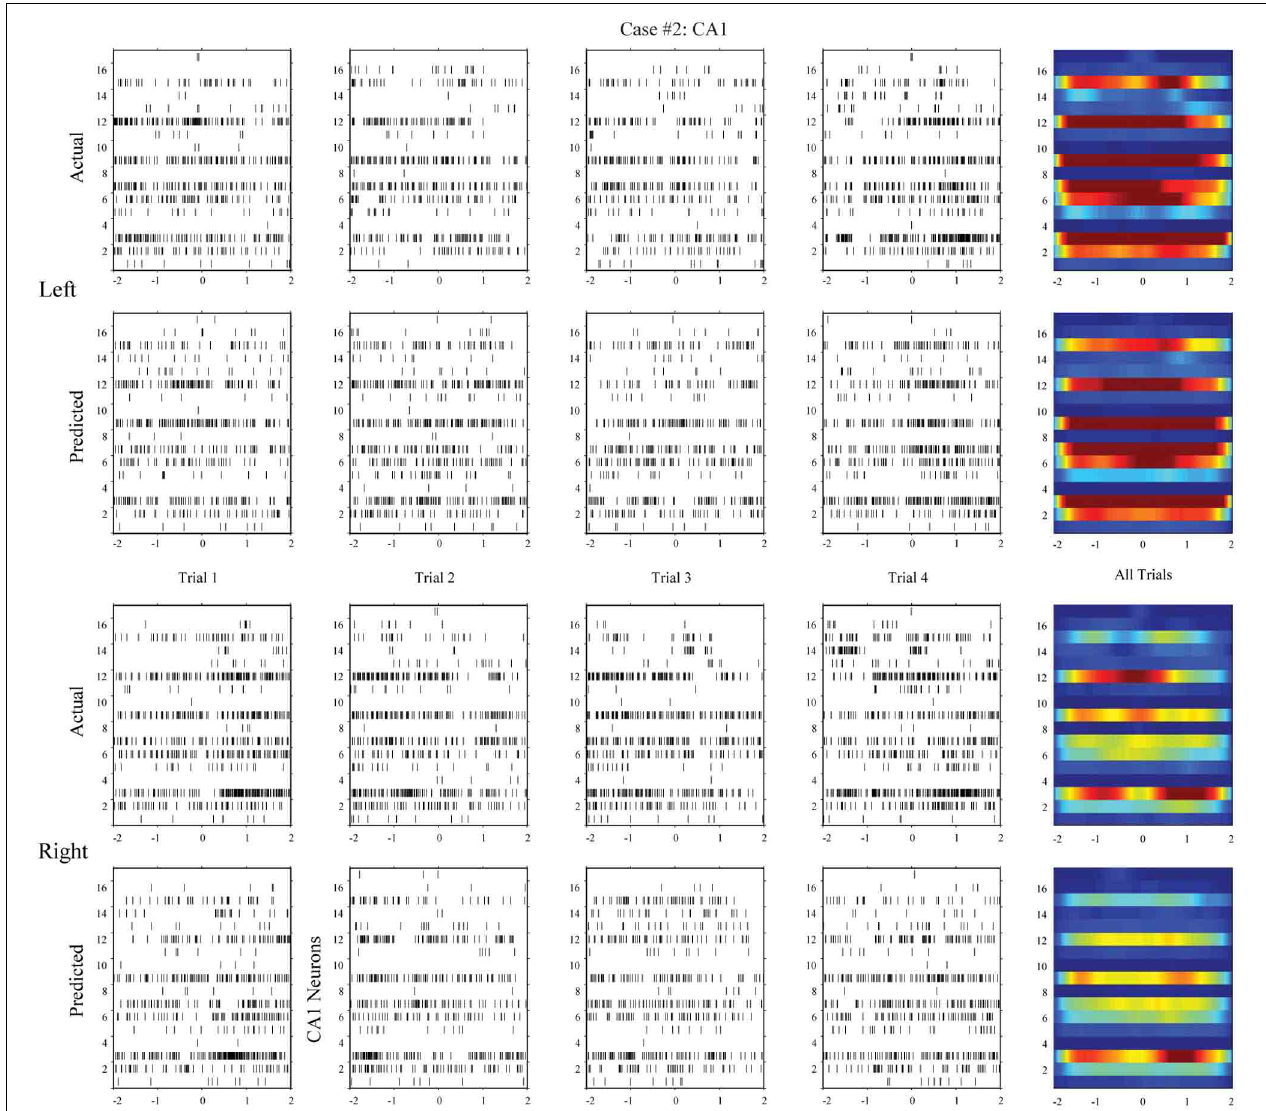
FIGURE 7 | Hippocampal CA1 spatio-temporal patterns (actual and MIMO model predicted) from a different animal (case